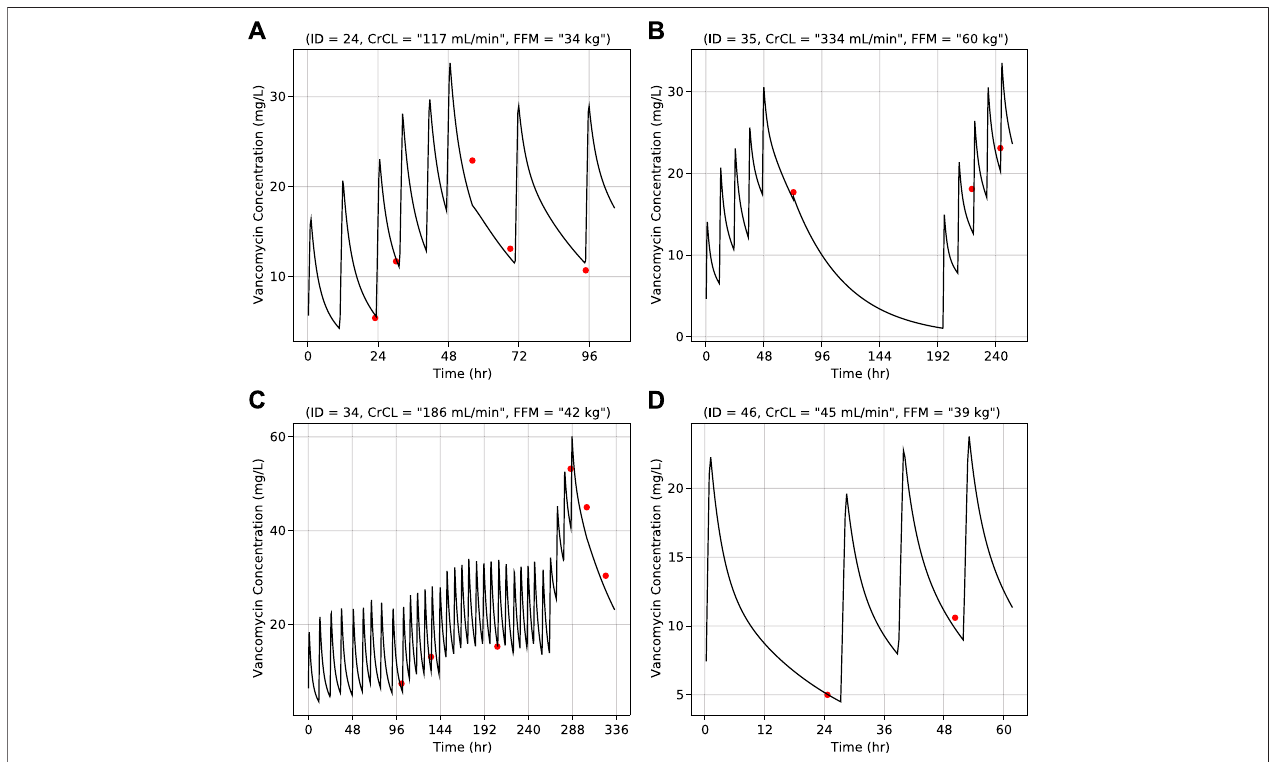
FIGURE 2 | Vancomycin concentration vs. time for individual representative subjects – (A) Normal creatinine clearance and low fat-free mass (B) High creatinine clearance and high fat-free mass (C) Normal creatinine clearance and normal fat-free mass (D) Low creatinine clearance and normal fat-free mass. Lines (black) represent predicted concentrations and dots (red) represent observed concentrations. Values of creatinine clearance and fat-free mass are at baseline.